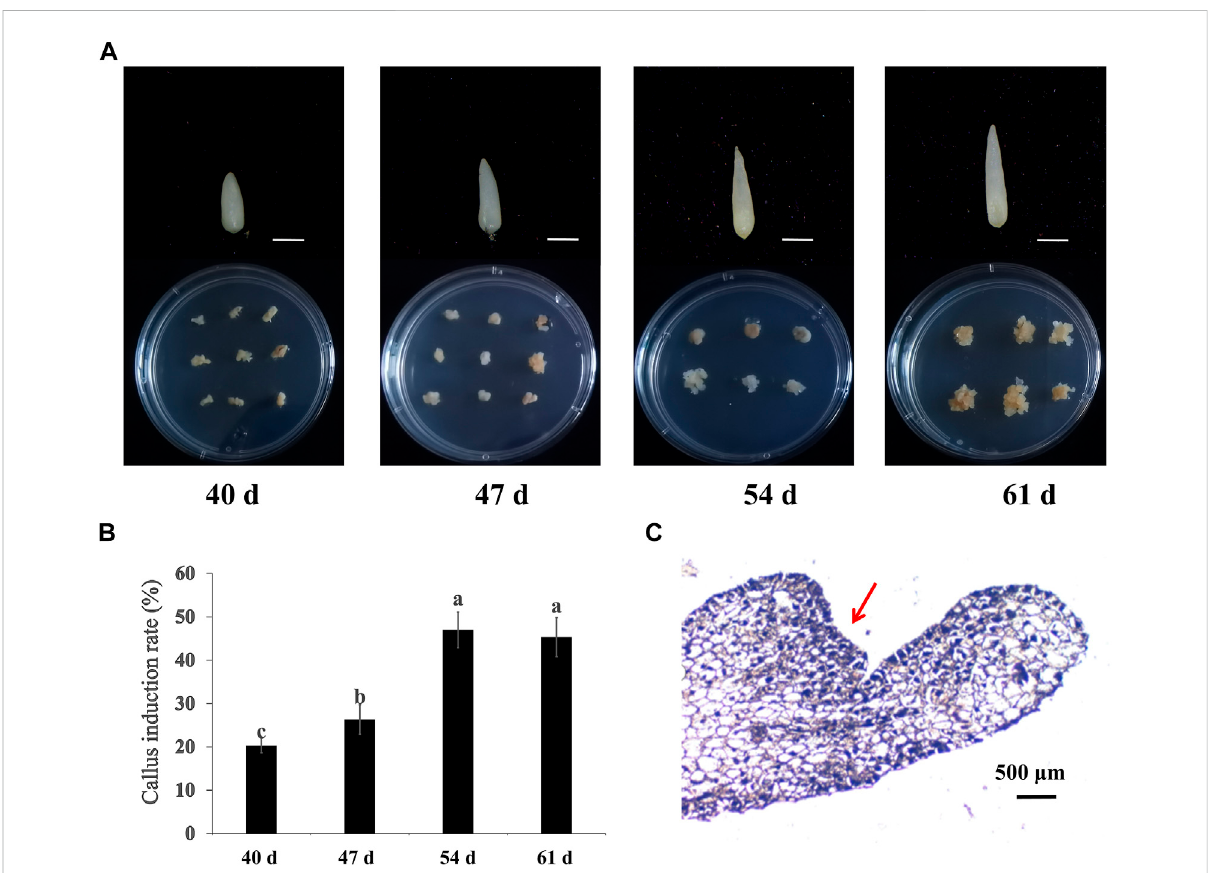
FIGURE 1 Embryonic callus induced from hybrid seeds embryo of cv. “ Black Magic ” × “ Liming ” at different maturity. (A) Induction of seed embryos at different stages and callus at 21 days. Scale bars, 500 μ m (B) Callus induction rates of seed embryos of different maturity levels. (C) Paraf fi n section observation of embryogenic